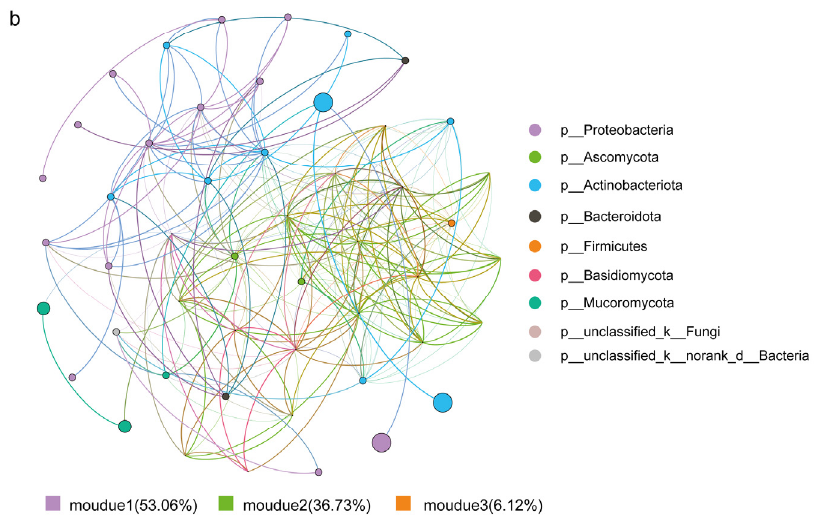
Figure 6. Co-occurrence network analysis of FFM ( a ) and AFM ( b ). Nodes are colored according to the phyla type, and nodes connected with the same color are of the same module. (r > 0.6, p < 0.05).